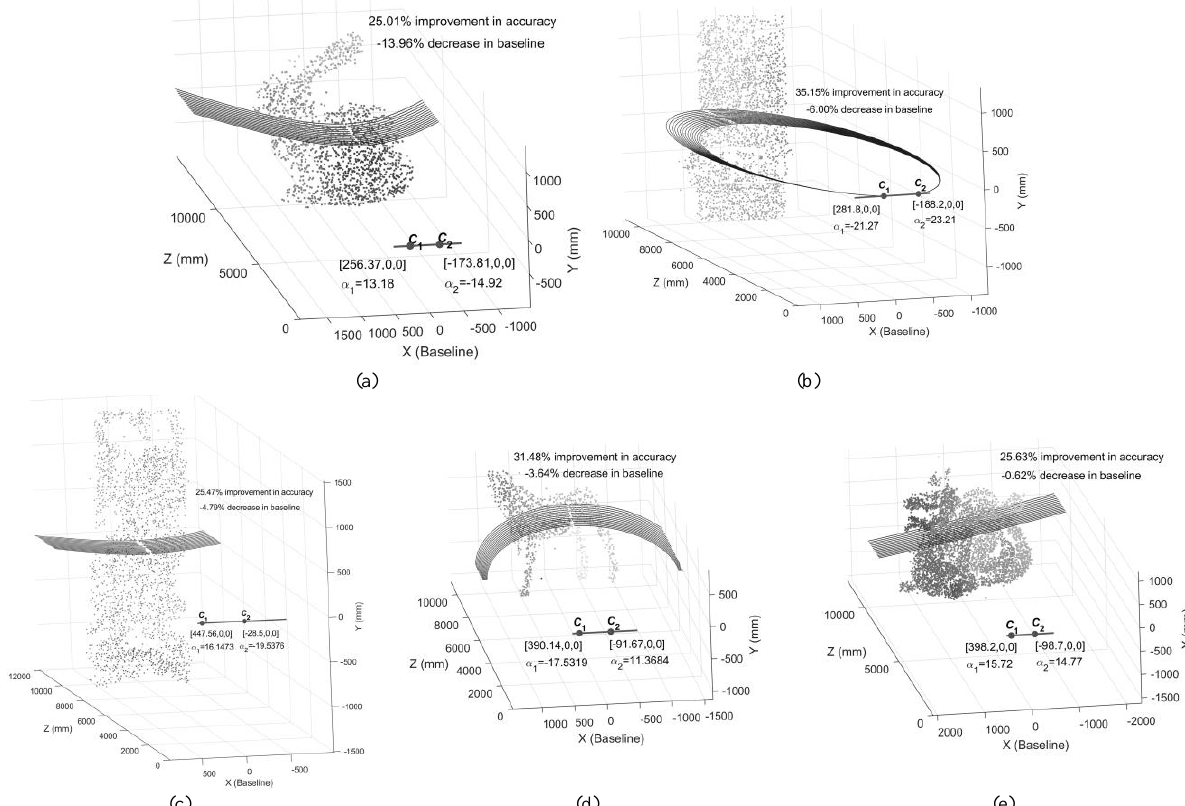
Figure 5. Optimized camera parameters and the associated iso-disparity layers for (a) the Stanford Bunny (b) the Turbine Blade (c) the happy Buddha, (d) The Horse and (e) the